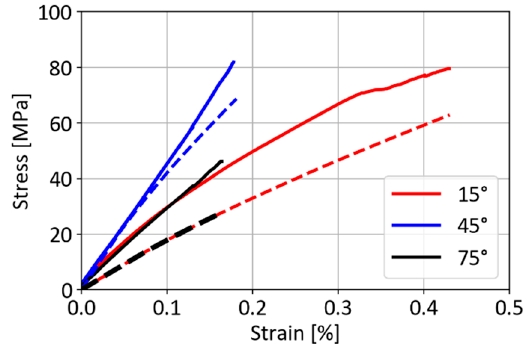
Figure 8. Comparison between the stress–strain curves obtained from the simulation (broken line) and Iosipescu shear tests (solid line) with different fiber orientations for C/C–SiC.